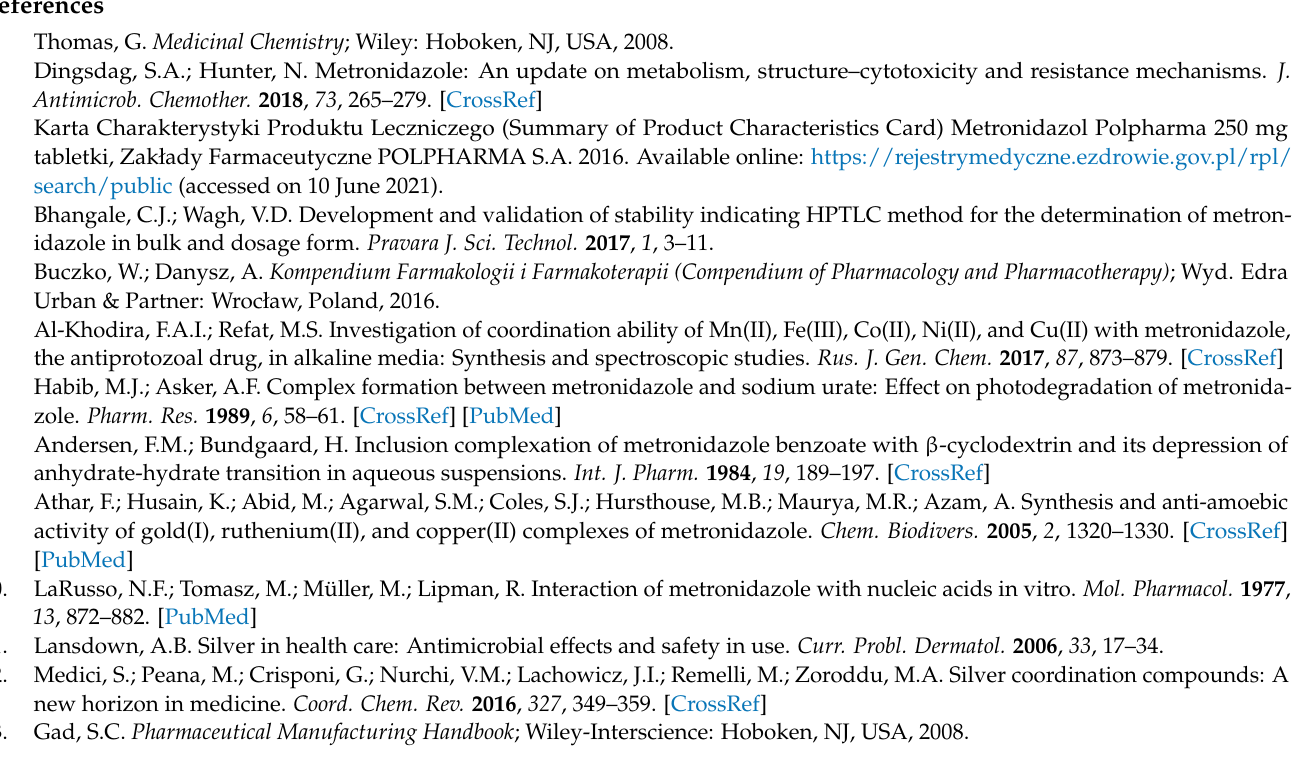
idazole, Table S2. Concentration [%)] of MTZ standard substance in solutions of different pH, Table S3. Concentration [%] of MTZ in the form of complex I in solutions of different pH, Table S4. Concentra- tion [%] of MTZ in the form of complex II in solutions of different pH, Table S5. Concentration [%] of MTZ in the solution of tablets at different pH, Table S6. Concentration [%] of MTZ in 3% hydrogen Table S8. Concentration [%] of MTZ in methanolic solutions exposed to sunlight irradiation, Table S9. Concentration [%] of MTZ (solid state) exposed to sunlight irradiation, Table S10. Statistical param- eters describing the relationship lnc = f(t) for the MTZ solutions, Table S11. Statistical parameters describing the relationship lnc = f(t) for the complex I solutions, Table S12. Statistical parameters describing the relationship lnc = f(t) for the complex II solutions, Table S13. Statistical parameters de- scribing the relationship lnc = f(t) for the tablet solutions, Table S14. Statistical parameters describing the relationship lnc = f(t) for UV irradiated